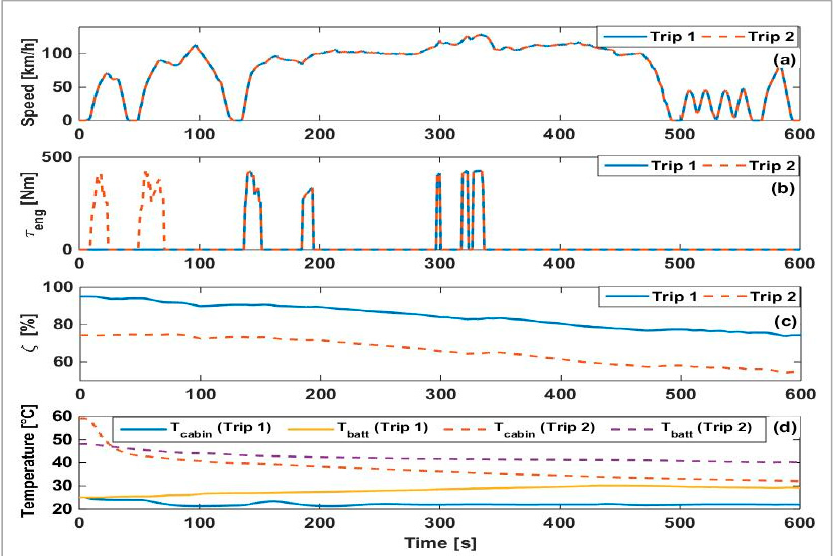
Figure 5. Simulation results: variations in ( a ) vehicle speed; ( b ) engine torque; ( c ) battery SoC and ( d ) the temperature of the cabin and battery over the